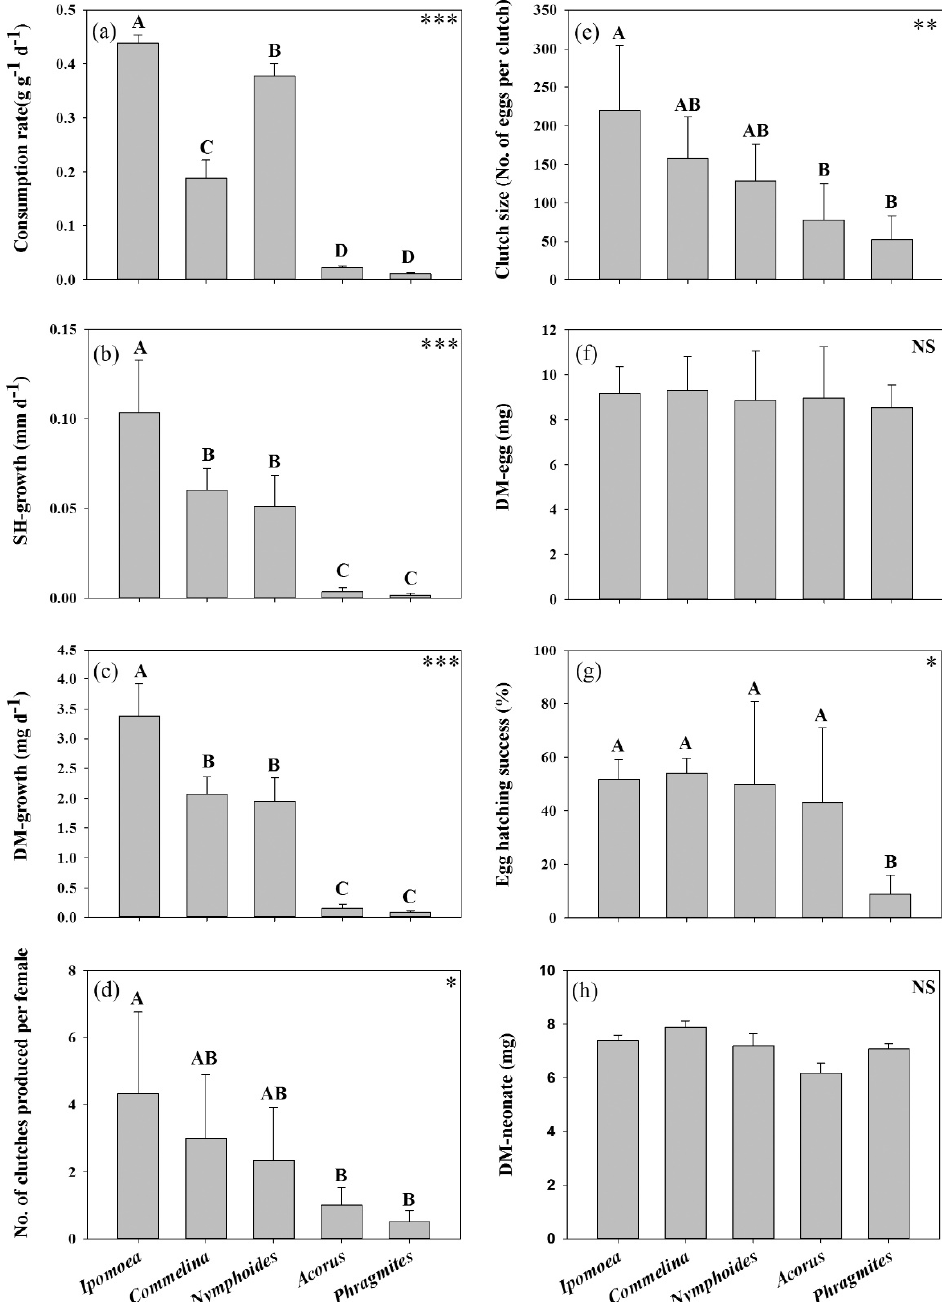
Figure 1. Mean (+ SD) of different responses of Pomacea canaliculata upon fed with the five study macrophyte species: ( a ) feeding rate; ( b ) SH-growth; ( c ) DM-growth; ( d ) Number of clutches produced per female; ( e ) Clutch size; ( f ) DM-egg; ( g ) Egg hatching success; ( h ) DM-neonate. * p < 0.05; ** p < 0.01; *** p < 0.001, NS no significance.